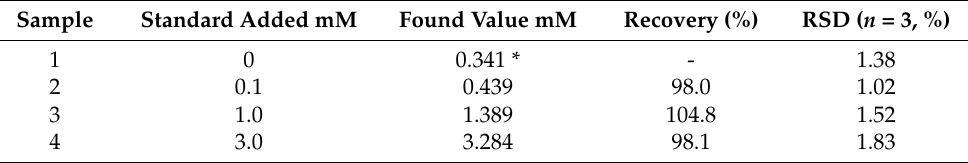
Table 4. Determination of glucose in serum samples.